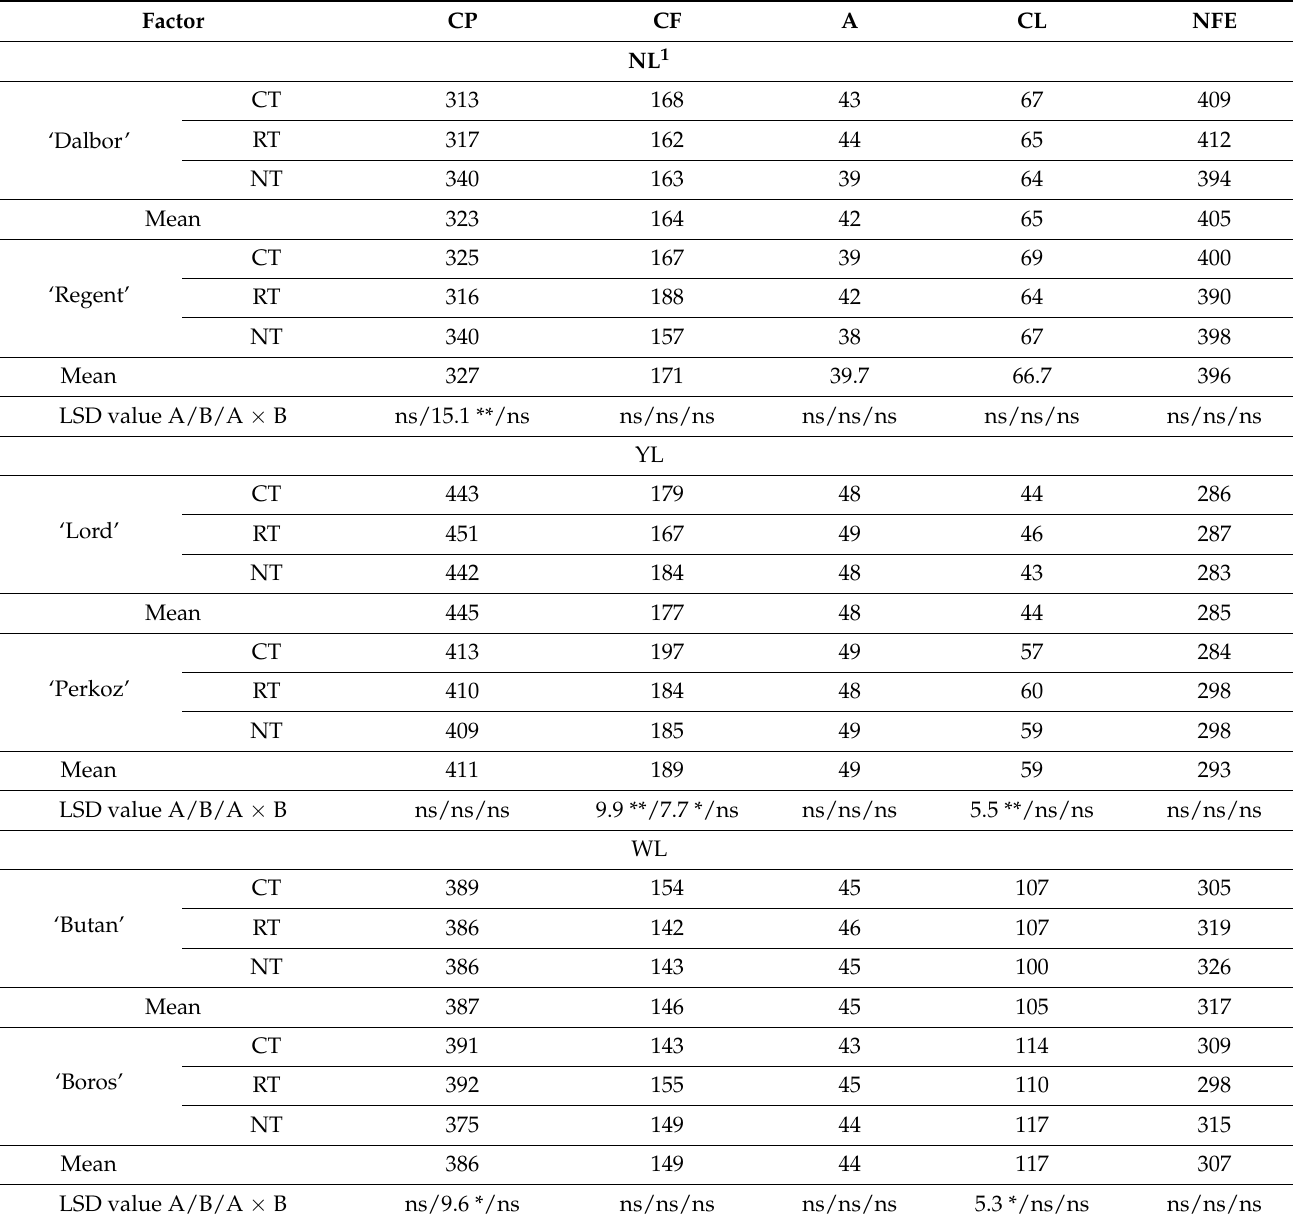
Table 2. Content (g kg − 1 DM) of organic components and ash in lupin seeds depending on the variety and tillage